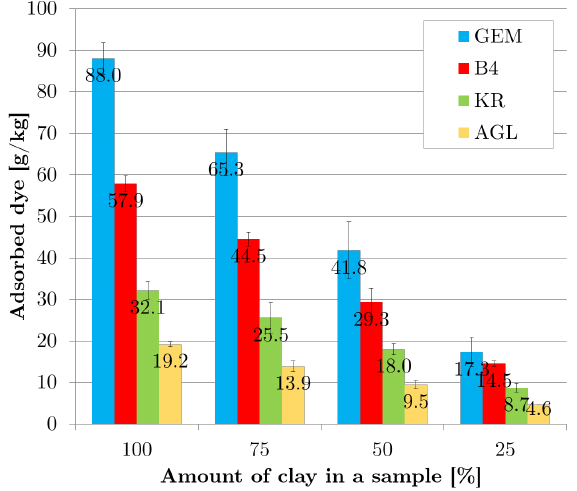
Figure 6. Amount of adsorbed methylene blue dye by